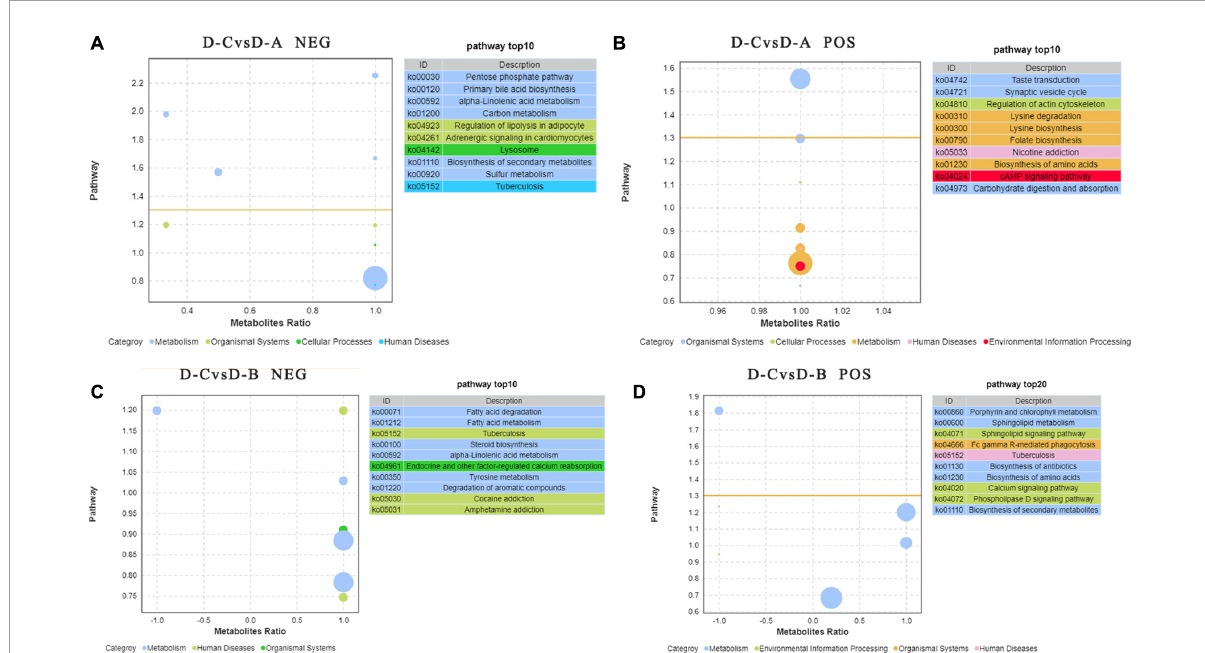
FIGURE7 Pathways with significant enrichment in differential metabolites were selected, and bubble maps were drawn using information about upregulation and downregulation. The X -axis represents the difference between the number of upregulated and downregulated differential metabolites as a percentage of total differential metabolites. The yellow line represents the threshold of P = 0.05. The Y -axis represents –log10 ( P -value). Different colors represent different categories. (A) Enrichment difference bubble chart of metabolites between D-C and D-A in the neg mode, (B) enrichment difference bubble chart of metabolites between D-C and D-A in the pos mode, (C) enrichment difference bubble chart of metabolites between D-C and D-B in the neg mode, and (D) enrichment difference bubble chart of metabolites between D-C and D-B in the pos